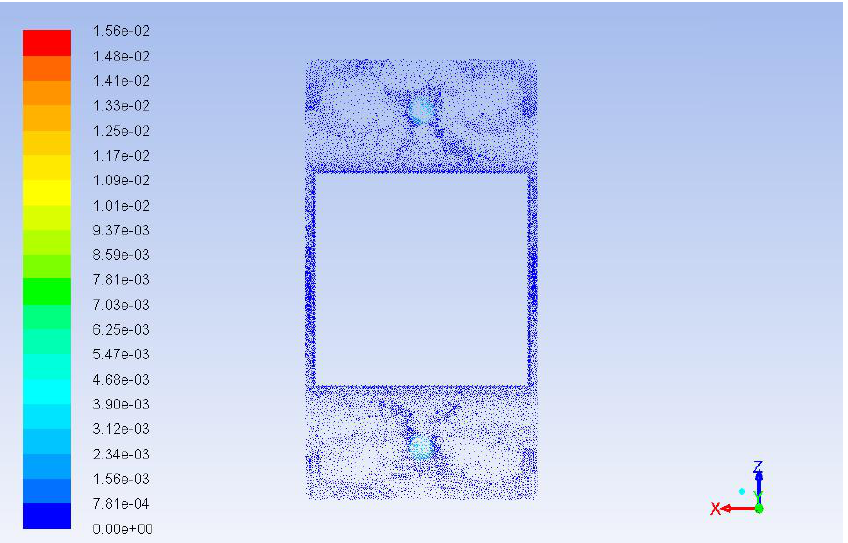
Figure 12. Velocity vector field (YZ projection, middle cross section, the reactor walls and the catalyst boundary are not shown, color map is indicated in m/s units).